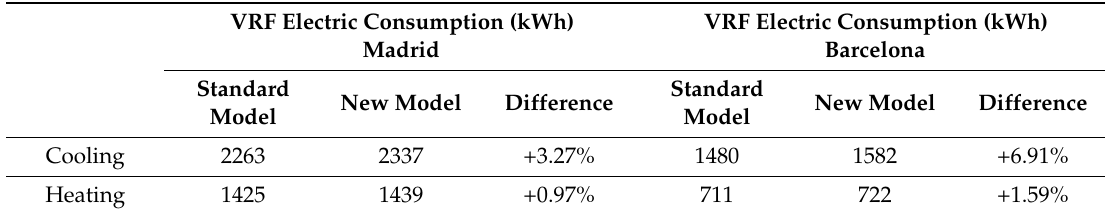
Table 3. Estimation of electric energy consumption with the standard and new model curves.